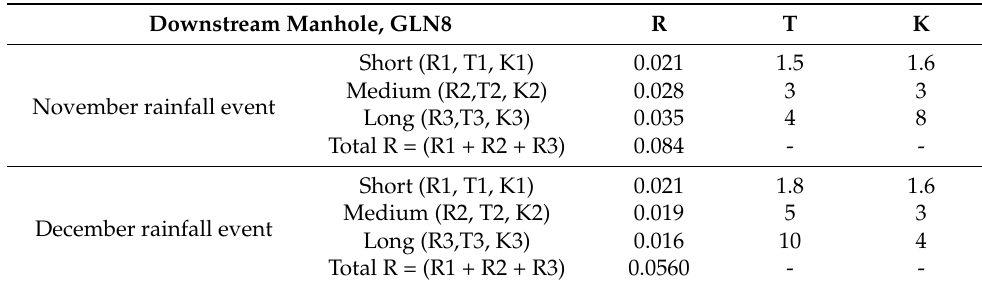
Table 2. R, T and K parameters at GLN8 manhole for the November and December intense rainfall